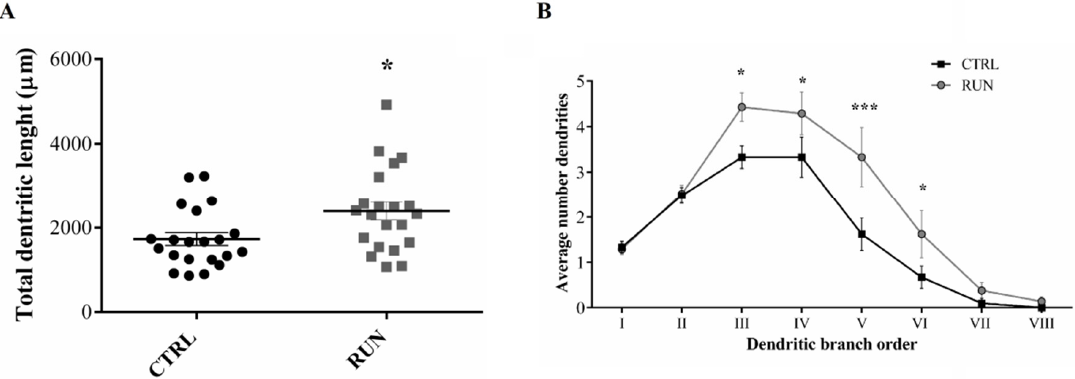
Figure 5. Morphological properties of 30-day-old granule cells. Comparison of total dendritic length ( A ) and dendritic tree complexity ( B ) between GFP-positive neurons of rats belonging to CTRL group (n = 21 cells) and RUN group (n = 21 cells). Statistical analyses: ( A ) unpaired Student’s t -test * p < 0.05; ( B ) multiple Student’s t -test * p < 0.05, *** p < 0.001. All data are expressed as mean ± SEM.